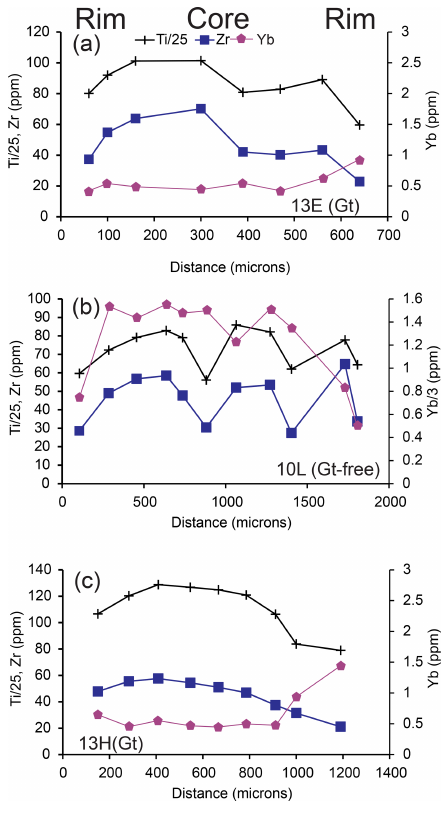
Figure 5. Core-to-rim trace element variation in clinopyroxene. (a) Type 1 clinopyroxene (sample 13E) from rim to rim; core is at ∼ 300µm. Ti and Zr are depleted in the rims. Yb is enriched in the right rim, where the clinopyroxene is in contact with plagioclase and garnet-breakdown products. (b) Garnet-free type 2 clinopyrox- ene (sample 10L) from rim to rim; core is at ∼ 1000µm. Ti and Zr are depleted in the rims. Yb is depleted in both rims. (c) Garnet- bearing type 2 clinopyroxene (Sample 13H) from rim to rim; core is at ∼ 600µm. Ti and Zr are depleted in the rims. Yb is enriched in the right rim, where the clinopyroxene is in contact with breakdown products of